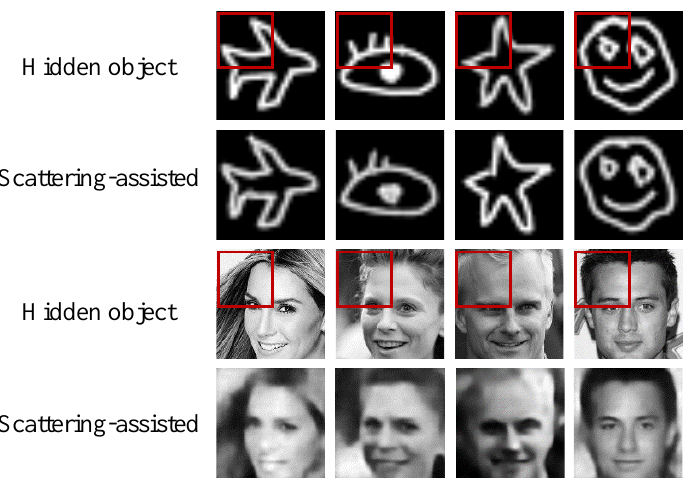
Figure 5. The scattering-assisted computational imaging result of complicated objects.